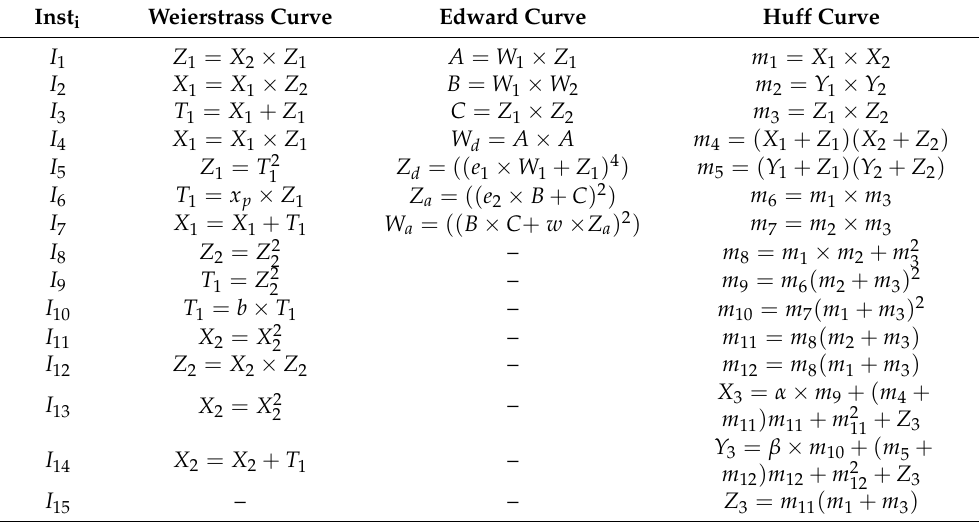
Table 1. Original PA and PD formulations for Weierstrass, Edward and Huff curves over GF ( 2 m ) . Inst i Weierstrass Curve Edward Curve Huff